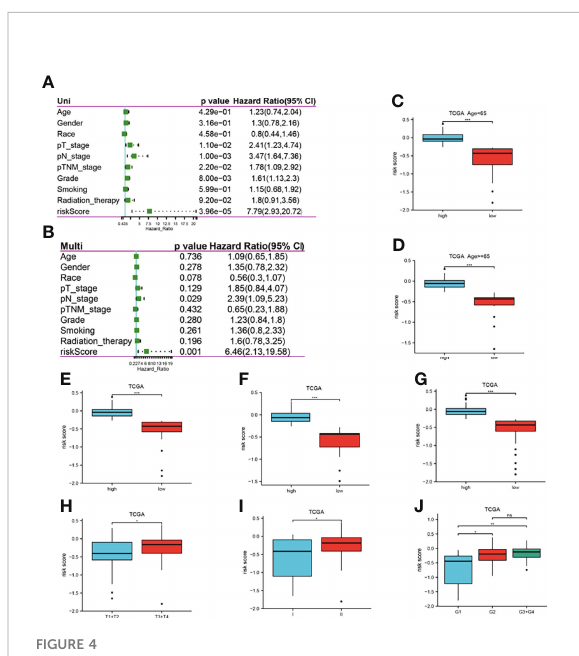
FIGURE 4 Correlation between risk scores and clinical traits in TCGA. (A, B) : P-value, HR, 95% CI for univariate and multifactorial Cox analysis of clinical traits and risk scores; (C – J) : Differences in expression of high and low risk scores in different clinical traits, respectively, age<65, age ≥ 65, male, female, Caucasian, T stage, pTNM stage, and tumor grade. *P<0.05, **P<0.01, ***P<0.001, ns, no signi fi